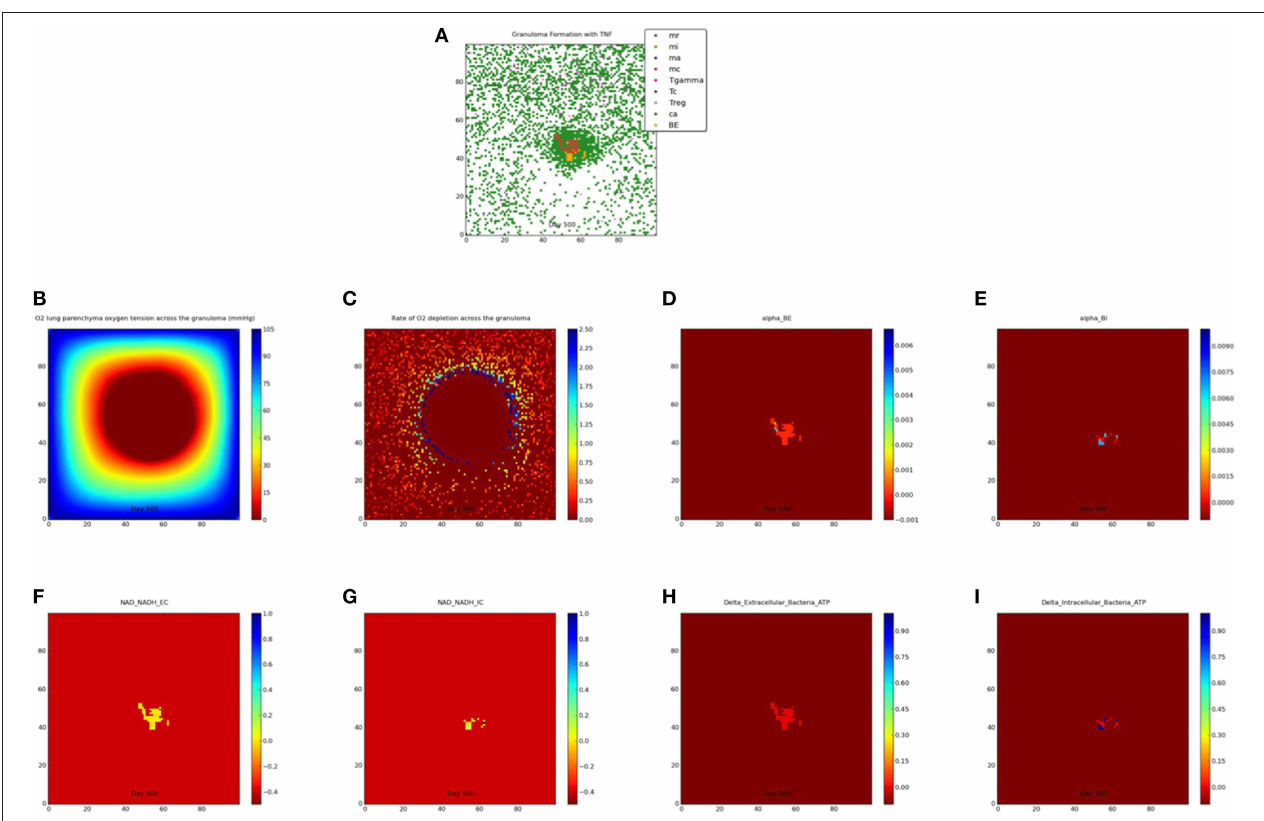
FIGURE 2 | Containment granuloma with TNF α , contains bacteria characterizable as in a state comparable to non-replicating persistence at 500 days. (A) Partial pressure of oxygen across the granuloma (B) oxygen depletion rate (C) bacterial growth rates for extracellular (D) and intracellular (E) bacteria; scaled NAD/NADH ratio for both extracellular (F) and intracellular (G) bacteria; change in ATP concentration for extracellular (H) and intracellular (I)